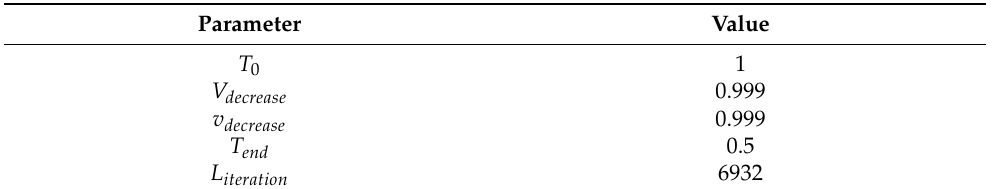
Table 3. Algorithm 2 simulation parameters.